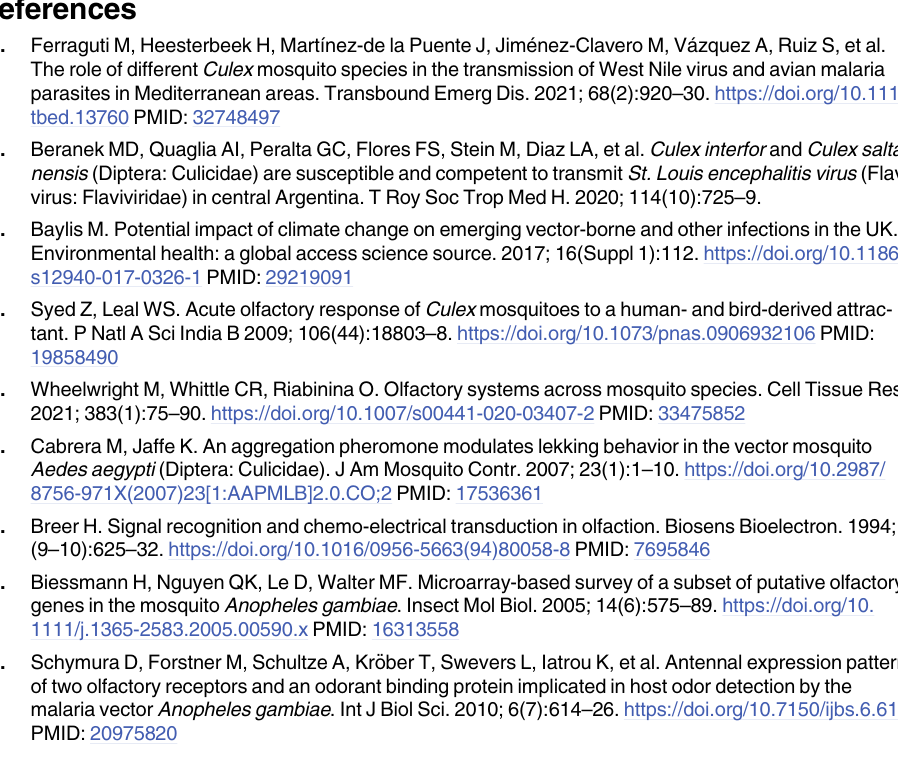
S1 Table. Primers designed and used in this study. Table A: The qPCR primers designed to verify olfactory genes; Table B : The primers used to synthesize